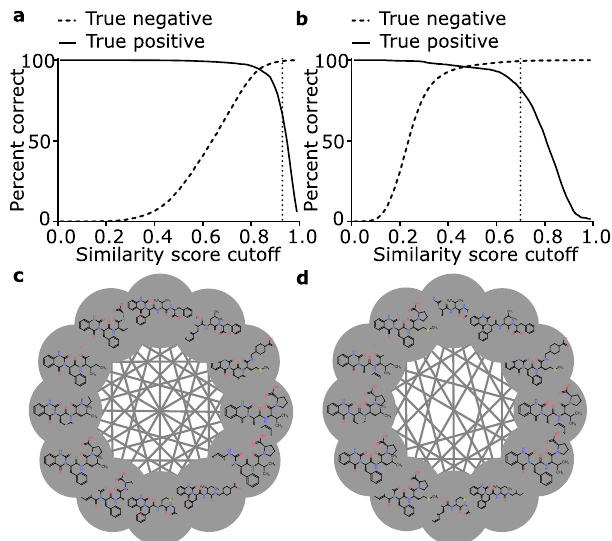
Fig. 2 | Alignment of cheminformatic chemical fi ngerprint similarity scoring with MS 2 spectral networking. Alignment between structural similarity networks generated using a MACCS fi ngerprinting with Dice scoring or b Morgan fi nger- printing (Radius = 2) with Dice scoring, with a molecular network created from GNPS public spectral library GNPS-NIH-NATURALPRODUCTSLIBRARY. True posi- tives are edges that exist between nodes in the molecular network while true negatives are edges which do not exist between nodes in the molecular network. Vertical dotted lines show the location where false connections equal 0.5%. c A subnetwork from the resulting GNPS network built from the NIH spectral libraries. d A structural similarity network built using the molecules present in panel c illustrating that the absence of selected edges does not substantively impact the interconnectivityofnodeswithinthegraph,Morgan fi ngerprinting(Radius=2)and minimum dice score of